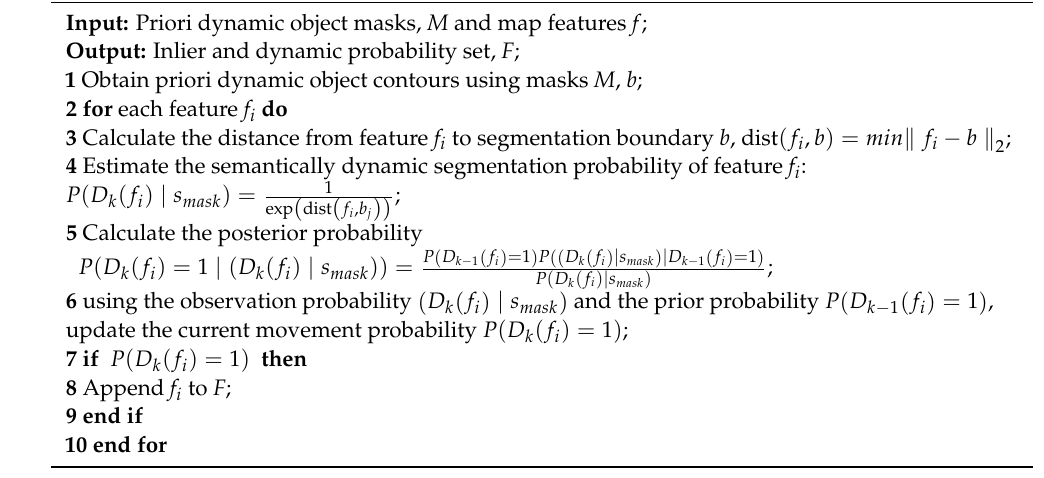
Algorithm 2: Outlier elimination algorithm of dynamic noise